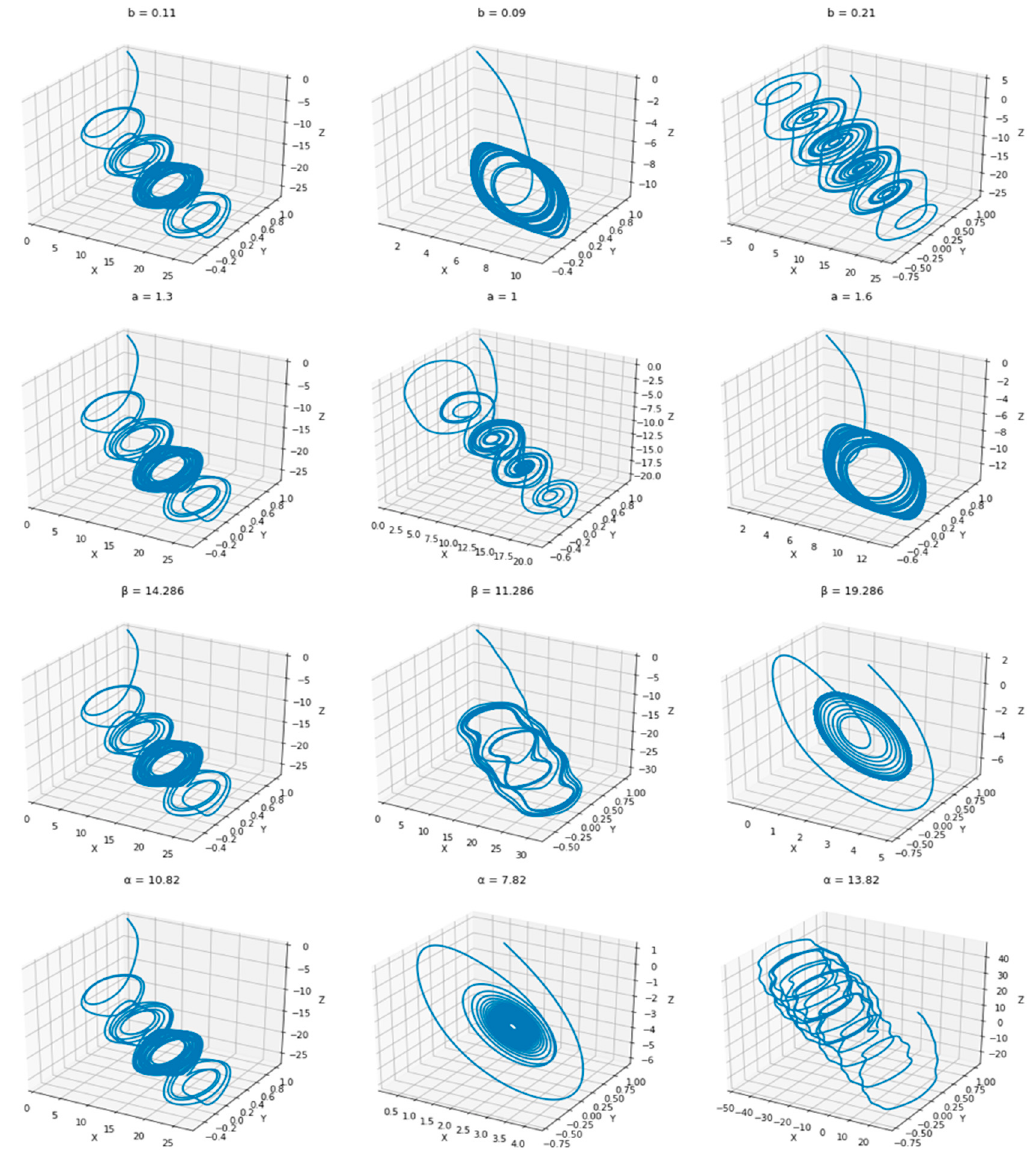
Figure 3. Graphic interpretation of changes to the parameters of an attractor.